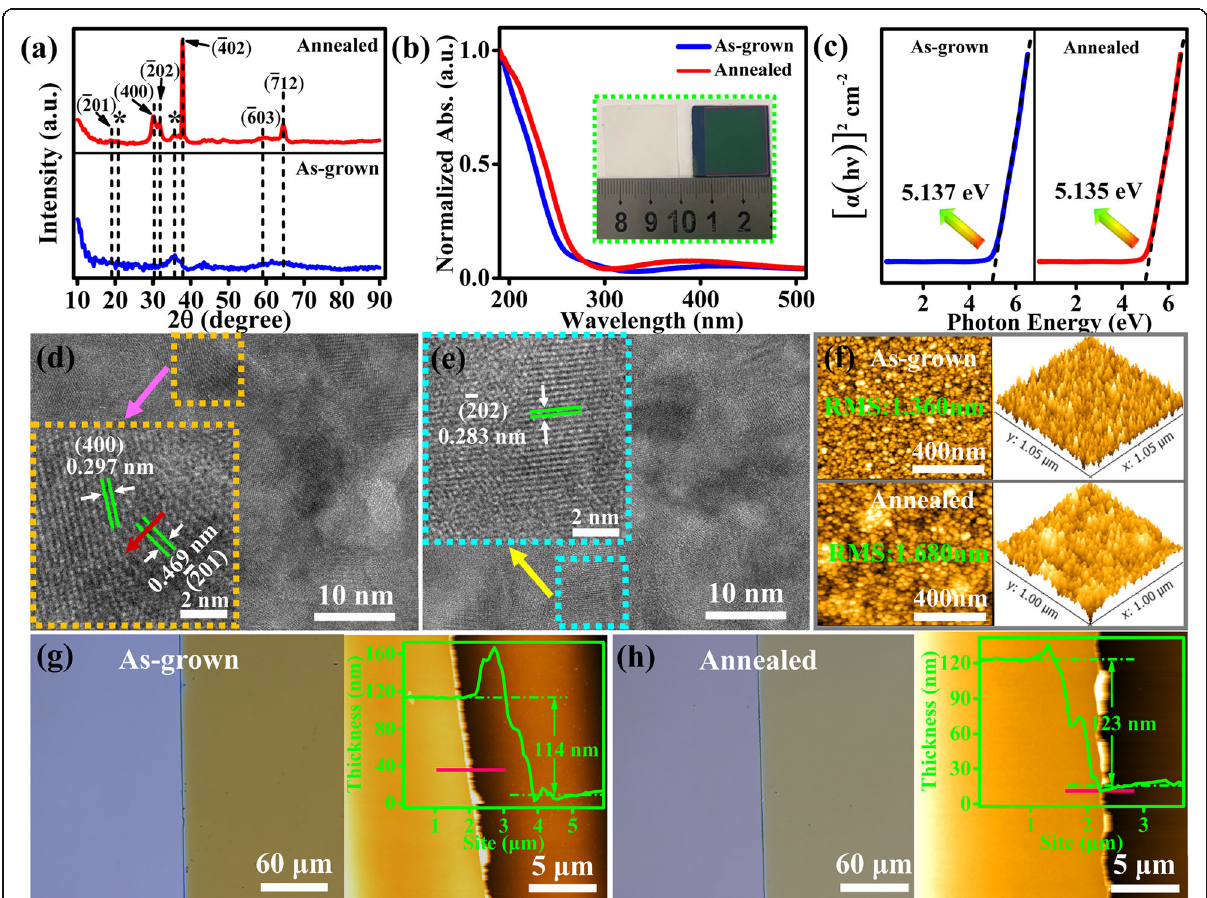
annealing. f AFM images of the β -Ga 2 O 3 film. g – h Optical and AFM images at the step edge between the film and